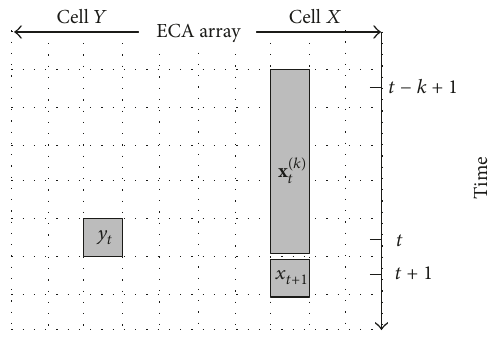
Figure 1: Time series of an ECA, with the pattern of cells relevant to the evaluation of the transfer entropy from 𝑌 to 𝑋 , 𝑇 𝑌→𝑋 , high-